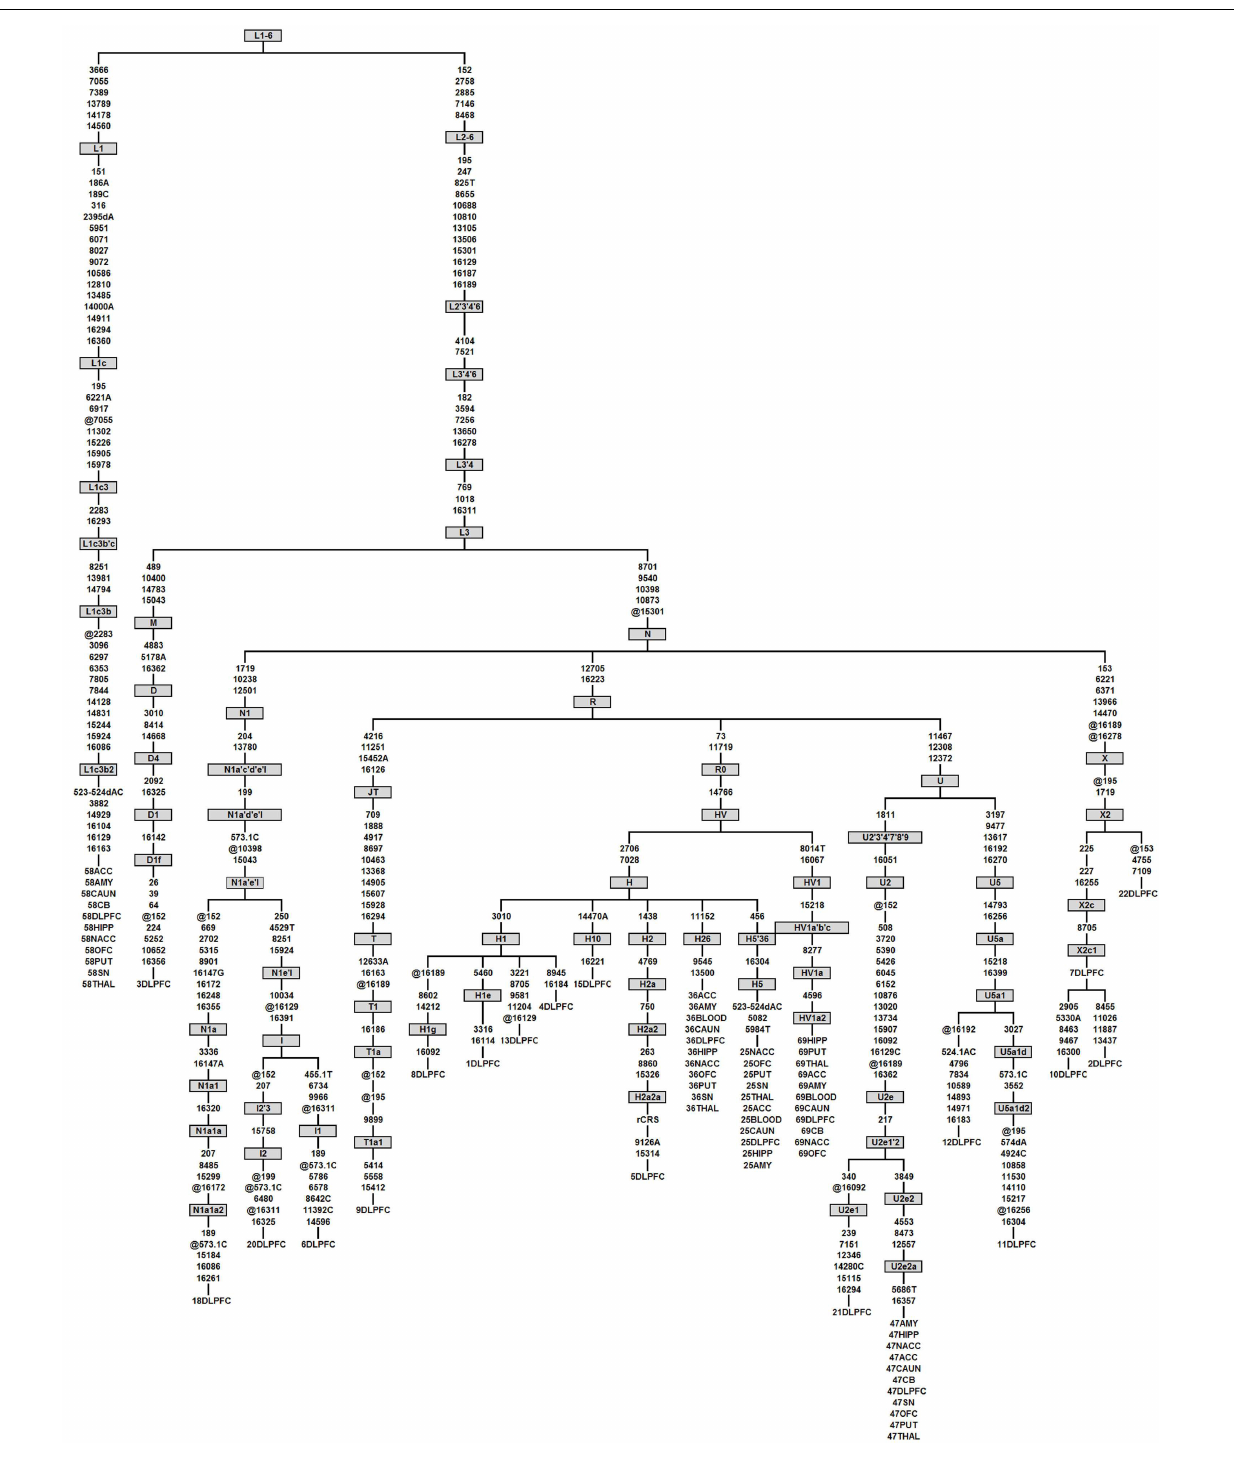
FIGURE 4 | Phylogenetic tree of the 23 complete mtDNA sequences generated in this study. Haplogroups are labeled in boxes and follow PhyloTree Build 12 nomenclature (van Oven and Kayser, 2009). Mutations are denoted as nucleotide position numbers corresponding to the rCRS. Mutations are transitions unless an exact base change is specified. Deletions and insertions are indicated by “d” and “0.1,” respectively, followed by the base(s) involved. Back mutations (from the perspective of the ancestral root) are preceded by “@.”Variants